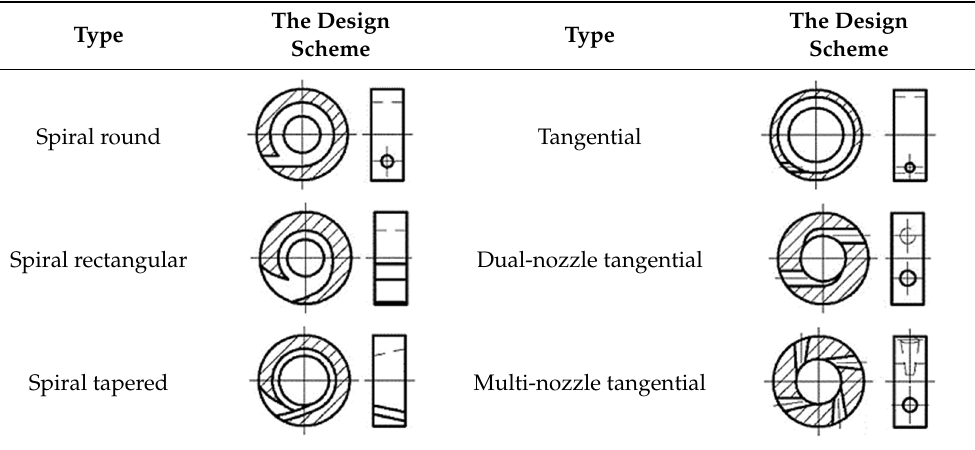
Table 1. Designs of active-flow inlet channels. Adapted with permission from Ref. [13]. 2018, Iurii Merzliakov.